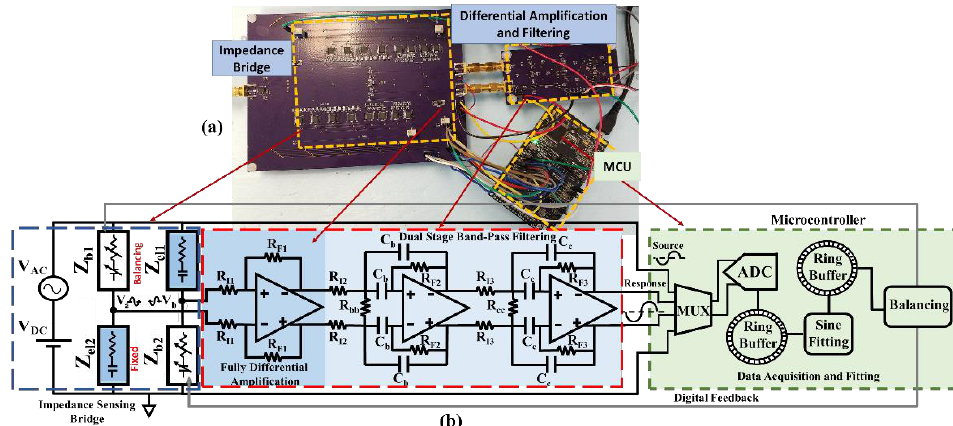
Figure 5. ( a ) The implemented amplification and filtering board interfaced with the differential impedance sensing unit: ( b ) The block diagram of the differential impedance sensing unit and the developed readout. The first amplification stage is placed on the same board as the sensing unit to avoid interferences with the small sensing response signal caused by external connections.